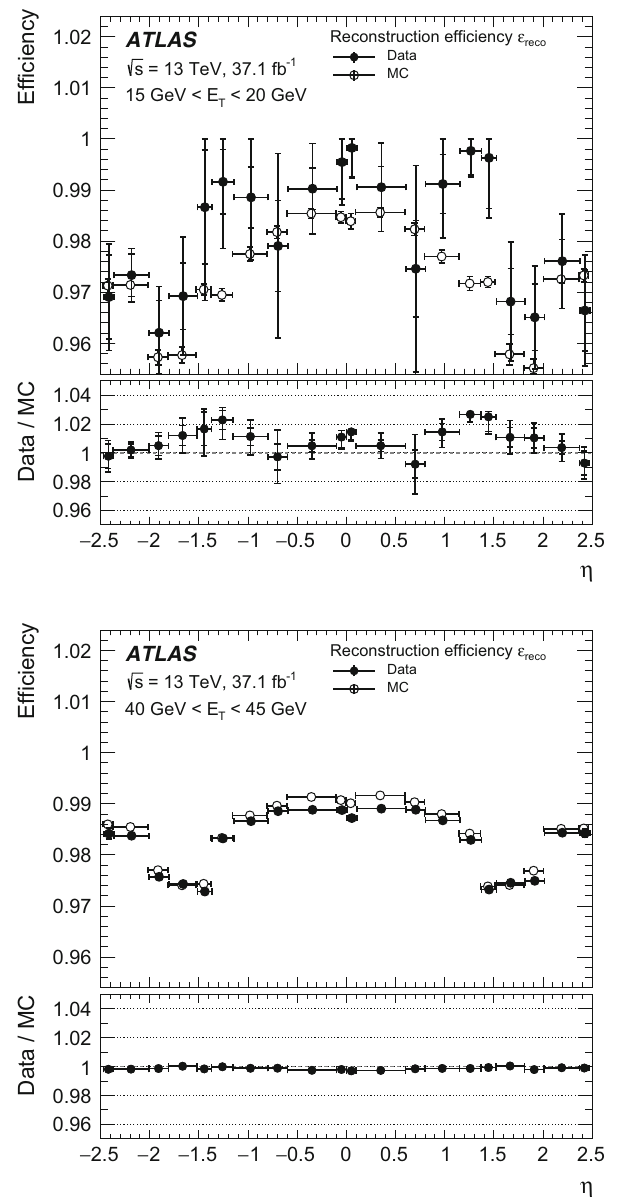
Fig. 4 Reconstruction efficiencies relative to reconstructed clusters, (cid:10) reco , evaluated in the 2015–2016 dataset (closed points) and in simu- lation (open points), and their ratio, using the Z → ee process, as a function of η in four illustrative E T bins: 15–20 GeV (top left), 25–